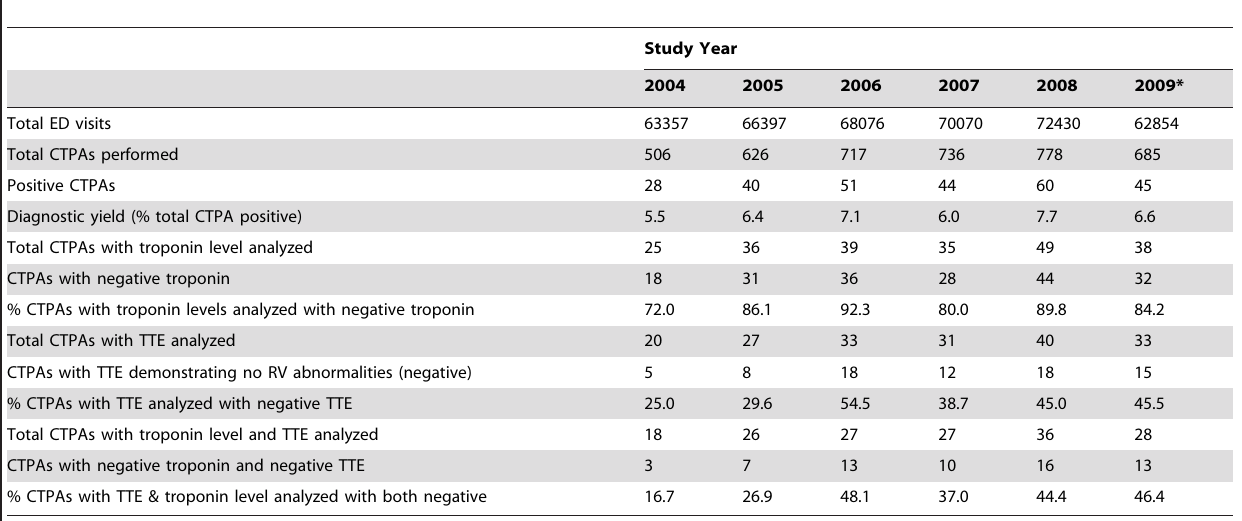
Table 2. Annualized CTPA utilization, diagnostic yield and disease severity data.